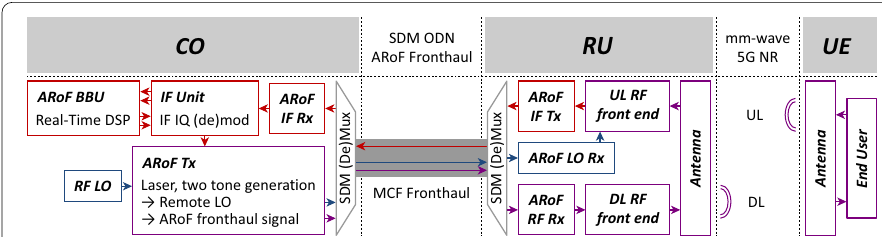
Fig. 3 Fronthaul architecture with CO, ARoF fronthaul over SDM based ODN, RU and mm-wave 5G NR air interface to the end user. CO: central office, RU: remote unit, UE: user equipment, ARoF: analog radio-over-fiber, SDM: space division multiplexing, ODN: optical distribution network, 5G NR: 5G new radio, RF: radio frequency, IF: intermediate frequency, BBU: baseband unit, DSP: digital signal processing, LO: local oscillator, MCF: multi-core fiber, DL: downlink, UL: uplink